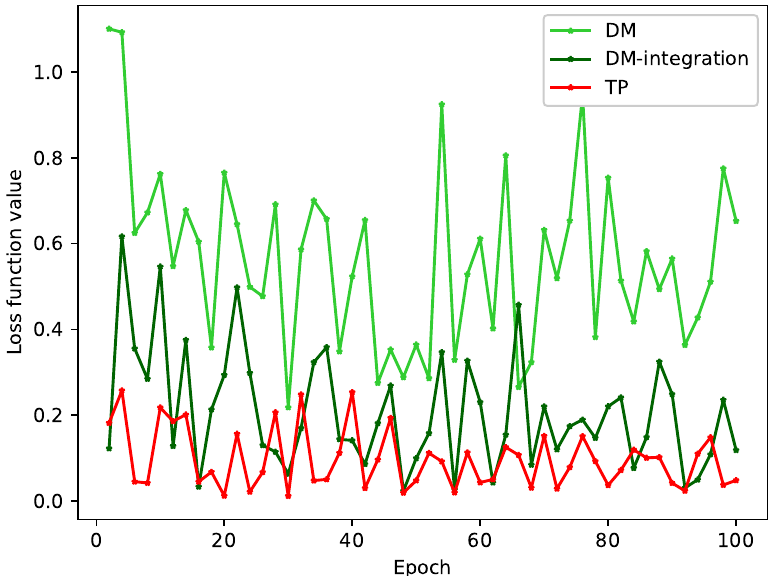
Figure 5. The convergence (oscillation) of the loss function values of DM, integration-DM, and TP methods.